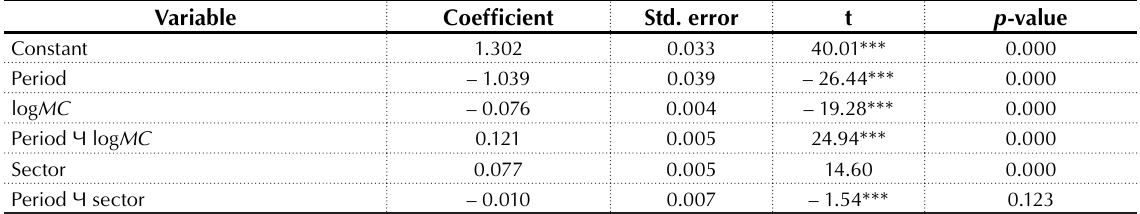
Table 7. Results of OLS regression for the liquidity measure TV (Model 2)